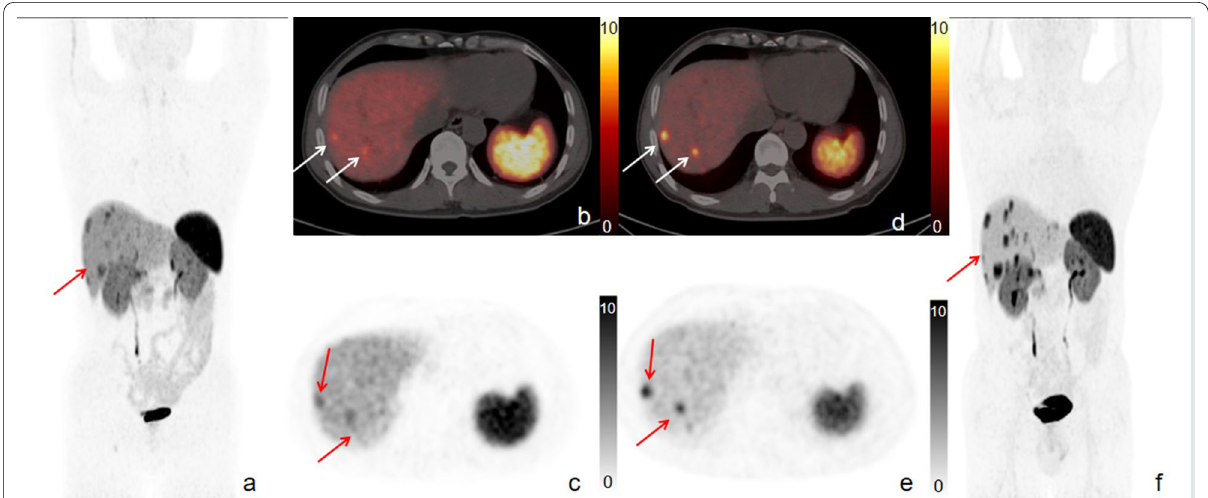
Fig. 2 More liver lesions were detected by 18 F-OC ( d–f ) than by 68 Ga-DOTATATE ( a – c ). Maximum intensity projection image ( a , f ) shows more liver metastases present in a 50-year-old patient with a grade II primary pancreatic neuroendocrine tumor. Although transaxial fused PET/CT ( b , d ) and PET images ( c , e ) acquired with 68 Ga-DOTATATE and 18 F-OC show an equal number of liver lesions in this slice, the lower background level of 18 F-OC uptake by normal liver ( d – f ) better delineates liver lesions by making the lesions appear to have more obvious uptake and sharper edges relative to background levels of 68 Ga-DOTATATE uptake ( a – c